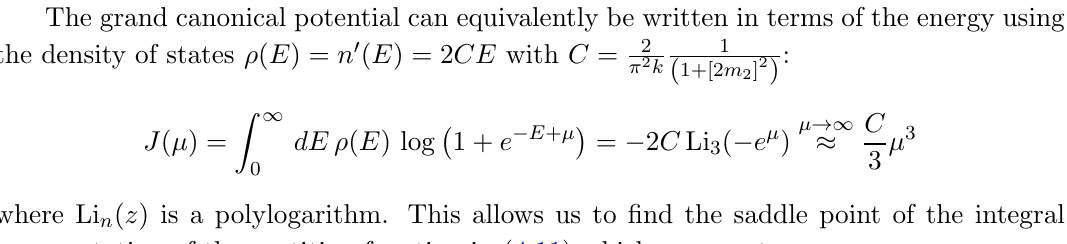
Figure 2 . Fermi surfaces for varying deformation m As the deformation increases, the diamond is